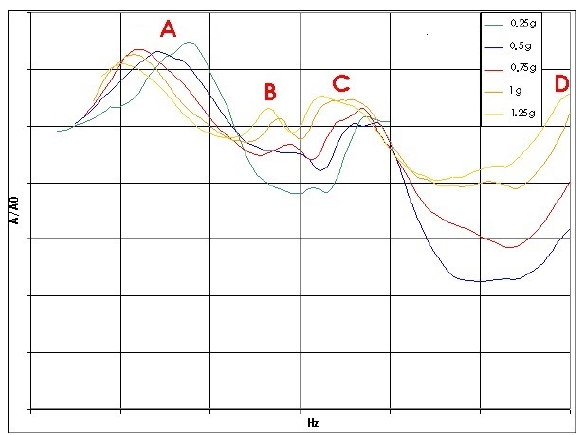
Figure 13. Rear unsprung mass frequency response. A piezometric accelerometer is fitted on the rear wheel hub. “A” is the sprung mass frequency contribution, “B” and “C” are the front and rear unsprung mass frequency contributions respectively while “D” is the contribution of the sprung mass pitch movement.